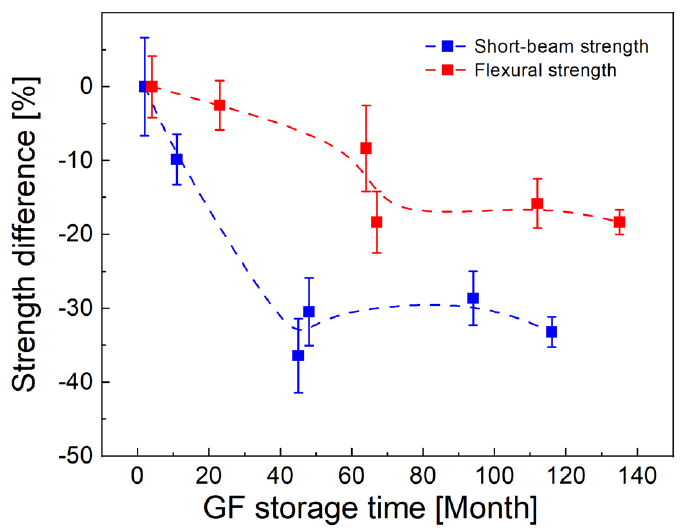
Figure 6. Effect of fiber storage time on short-beam strength and flexural strength of GF/polyester